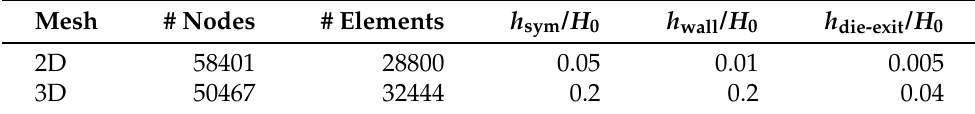
Figure 6. Three-dimensional mesh used in this study. Refinement factor at the die exit is 5. Table 3. Two and three-dimensional meshes for the swell problems in this paper.